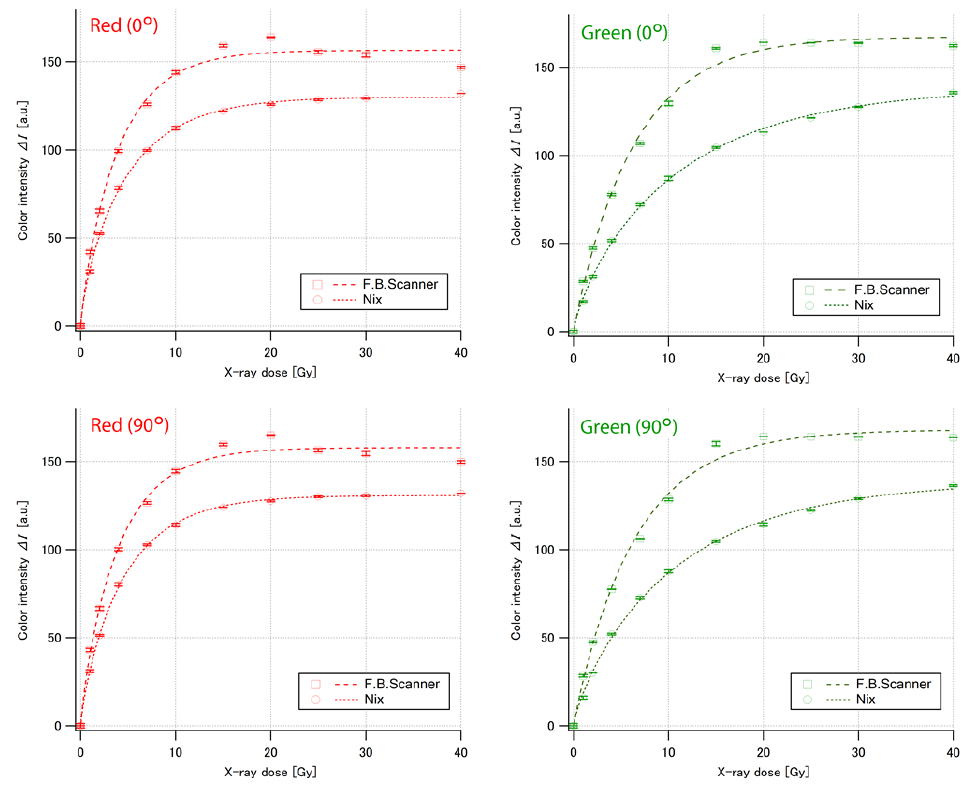
Figure 6. Comparison between the dose dependencies of the color intensities (( left ): red component, ( right ): green component) of EBT-XD measured with Nix and those with the flatbed scanner at the angles of 0° ( above ) and 90° ( below ).